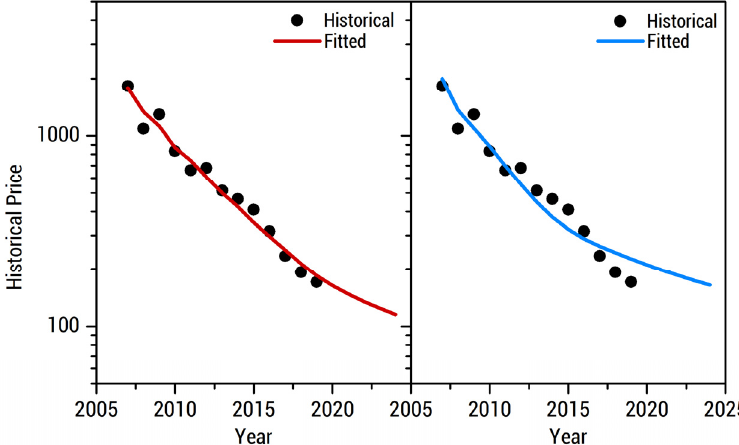
Figure 4. Li-ion NMC battery pack historical prices and predicted prices according to a single-factor learning by using ( left ) and learning by innovation ( right ) model.